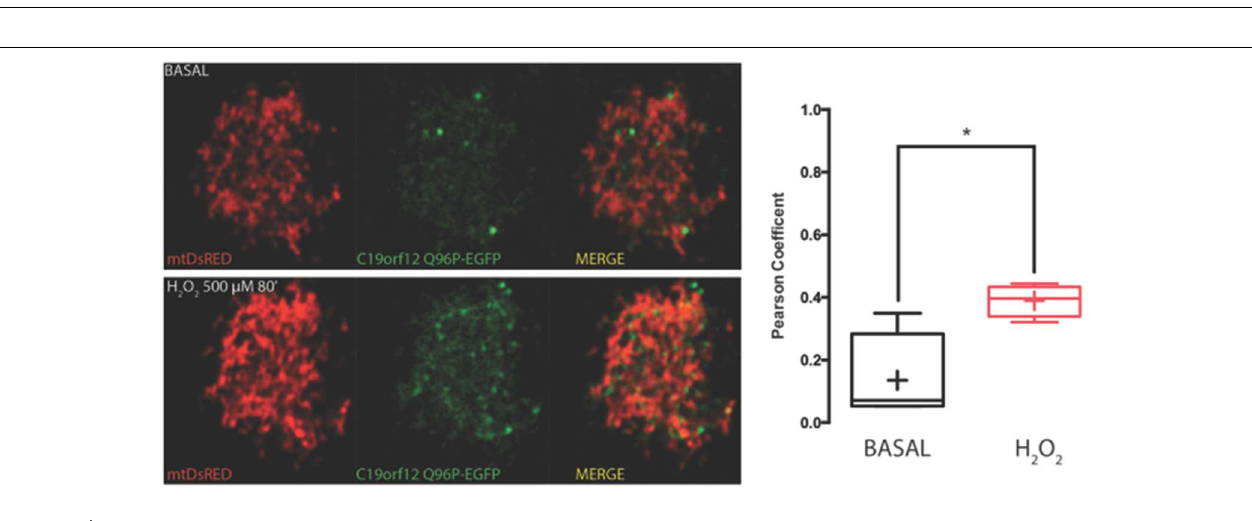
H 2 O 2 500 µ M. Quantitative analysis of EGFP and DsRed signal before and after oxidative stress (cross, average; line, median; box, 25 and 75 percentile; bars, max and min value, n = 8 , * , p > 0 . 05 ) is shown on the